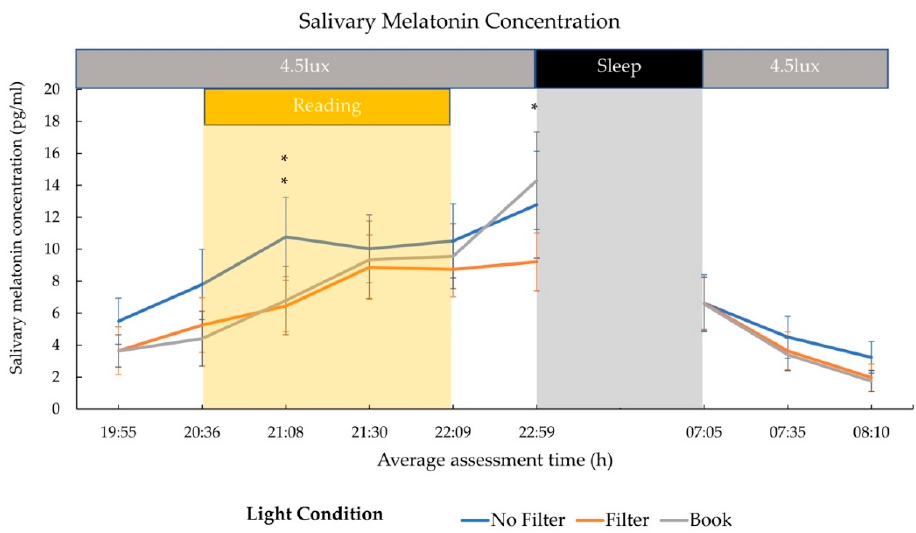
Figure 3. Trajectory of salivary melatonin concentration (mean and standard error). The 4.5 lux label corresponds to the background room lighting and refers to photopic lux. During the 8 h sleep interval, lights were switched off (0 lux). Melatonin concentration was higher in the “No Filter” condition than in both other conditions after 30 min of light exposure and higher in the “Book” condition compared to the “Filter” condition immediately before sleep. * = p ≤ 0.05.